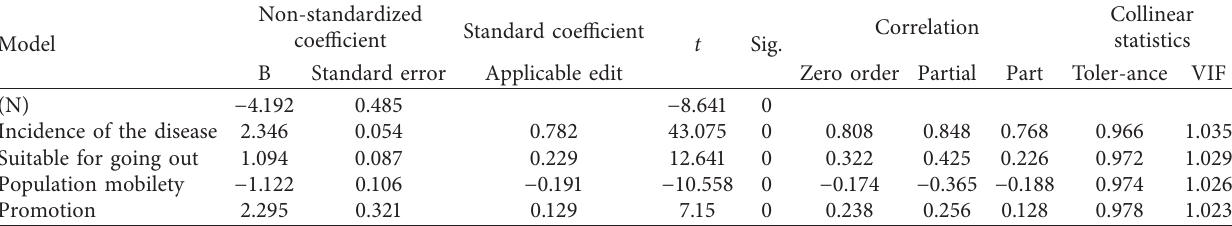
Table 11: Result test